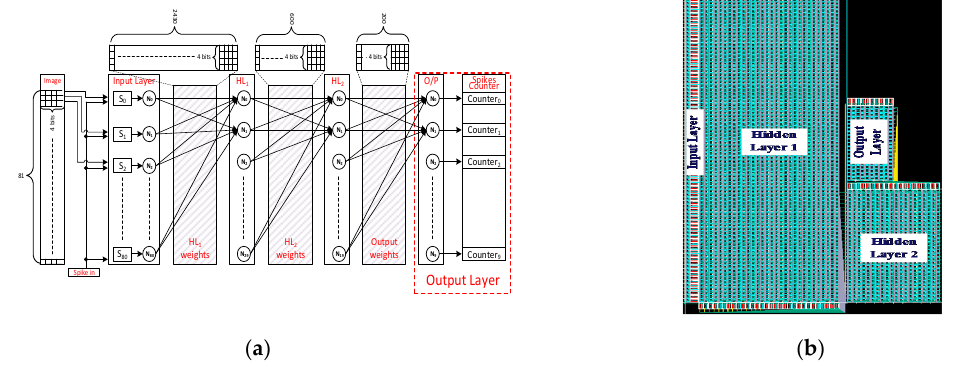
Figure 14. ( a ) The overall block diagram of the SNN chip optimized with BSRC 81-30-20-10 (4-bit quantized); ( b ) The full chip layout photo of the SNN chip under fabrication.